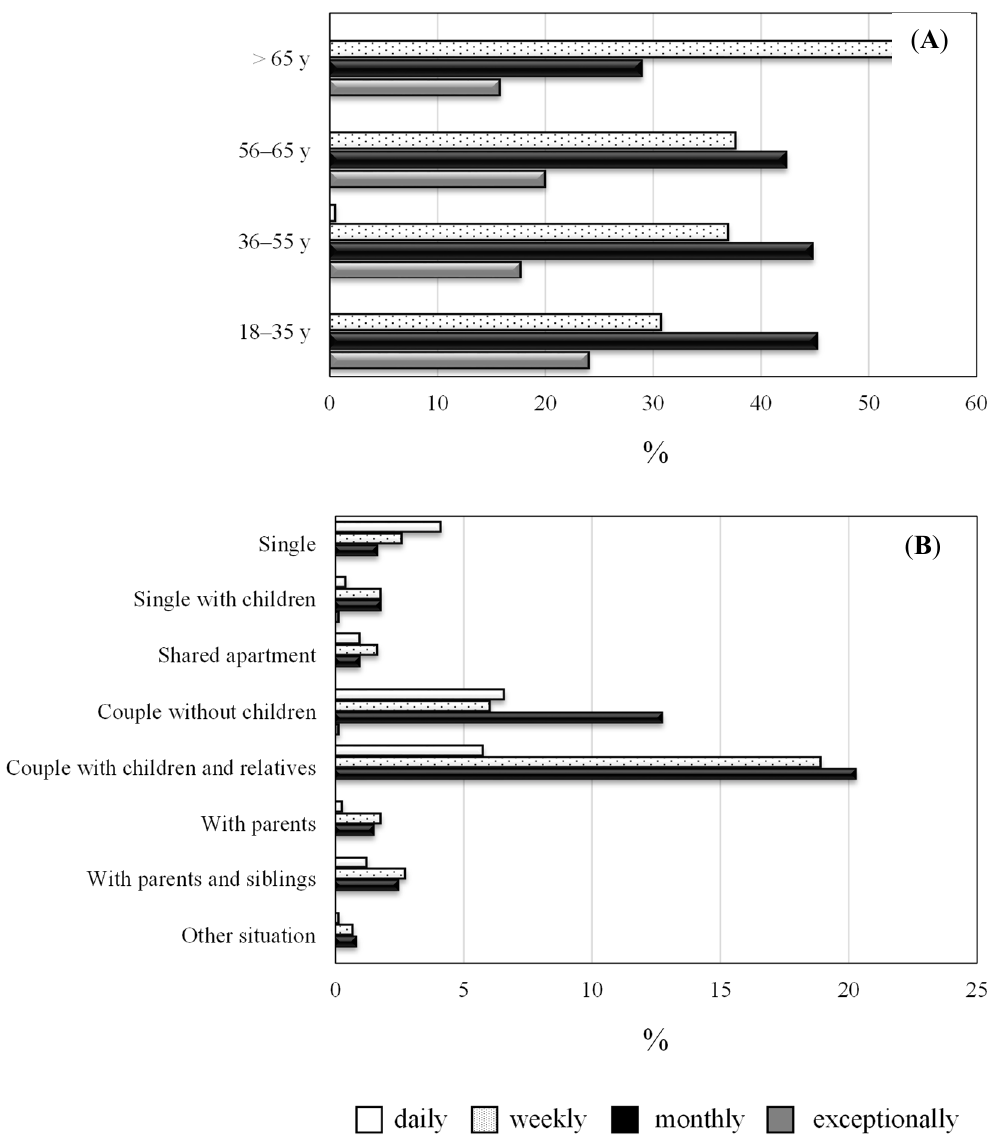
Figure 2. Distribution of french fry consumption according to participants’ age (expressed in relative amounts within each age group) ( A ) and the type of household (expressed in absolute amounts for all respondents ( B ): daily, weekly, monthly and exceptionally).